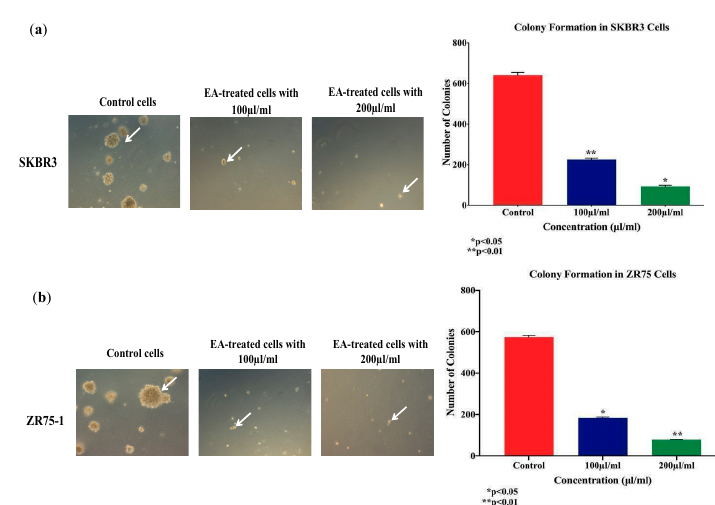
Figure 6. ( a , b ) Effect of EA flower extract on colony formation, in soft agar, in human HER2-positive cancer cell lines, SKBR3 ( a ) and ZR75-1 ( b ). EA extract inhibits colony formation of SKBR3 and ZR75-1, in comparison with their matched control cells (images of figure a , b at ×10 magnification). Colony formation in soft agar is a solid indicator of tumor formation in vivo. The colonies were counted manually and expressed as percentage of treatment relative to the control (mean ± SEM).